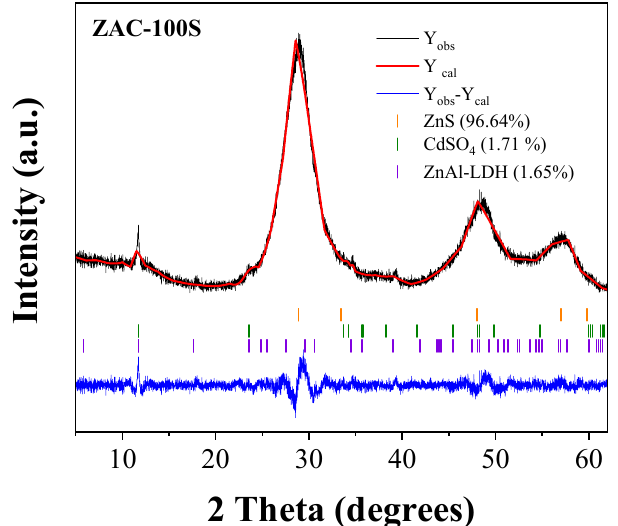
Figure 7. Rietveld analysis for the sample ZAC-100S.